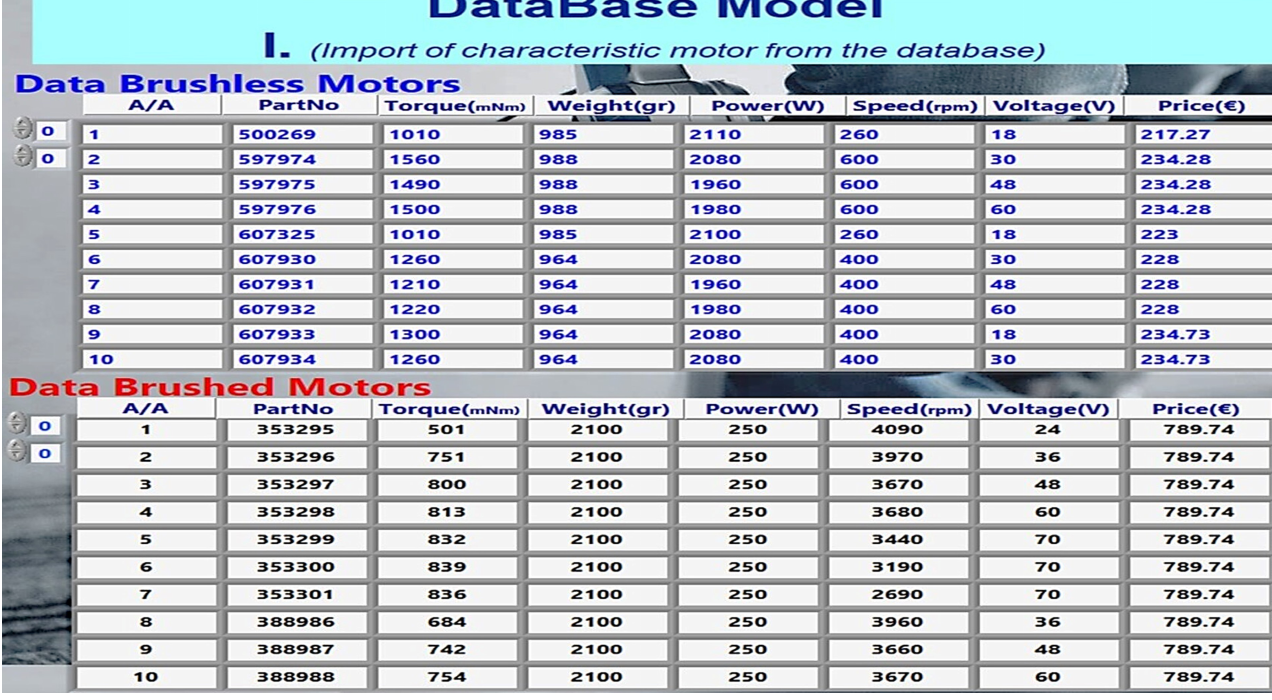
Figure 10. Characteristics of motors from